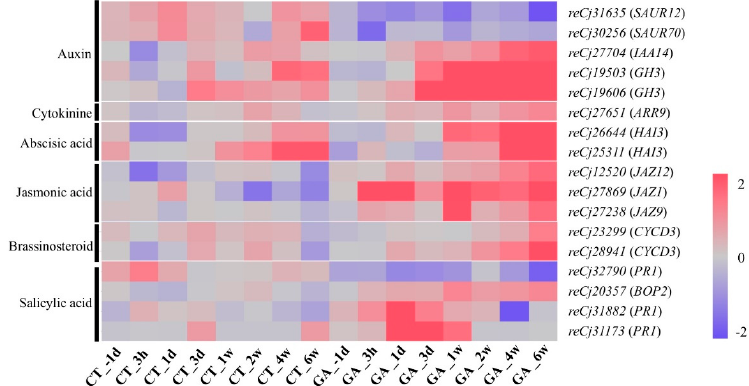
Figure 6. The heat map analysis associated with MADS-box genes. The relative expression values were log 2 transformed. Red indicates high expression; blue indicates low expression. CT_ − 1 d, CT_3 h, CT_1 d, CT_3 d, CT_1 w, CT_2 w, CT_4 w, CT_6 w, GA_ − 1 d, GA_3 h, GA_1 d, GA_3 d, GA_1 w, GA_2